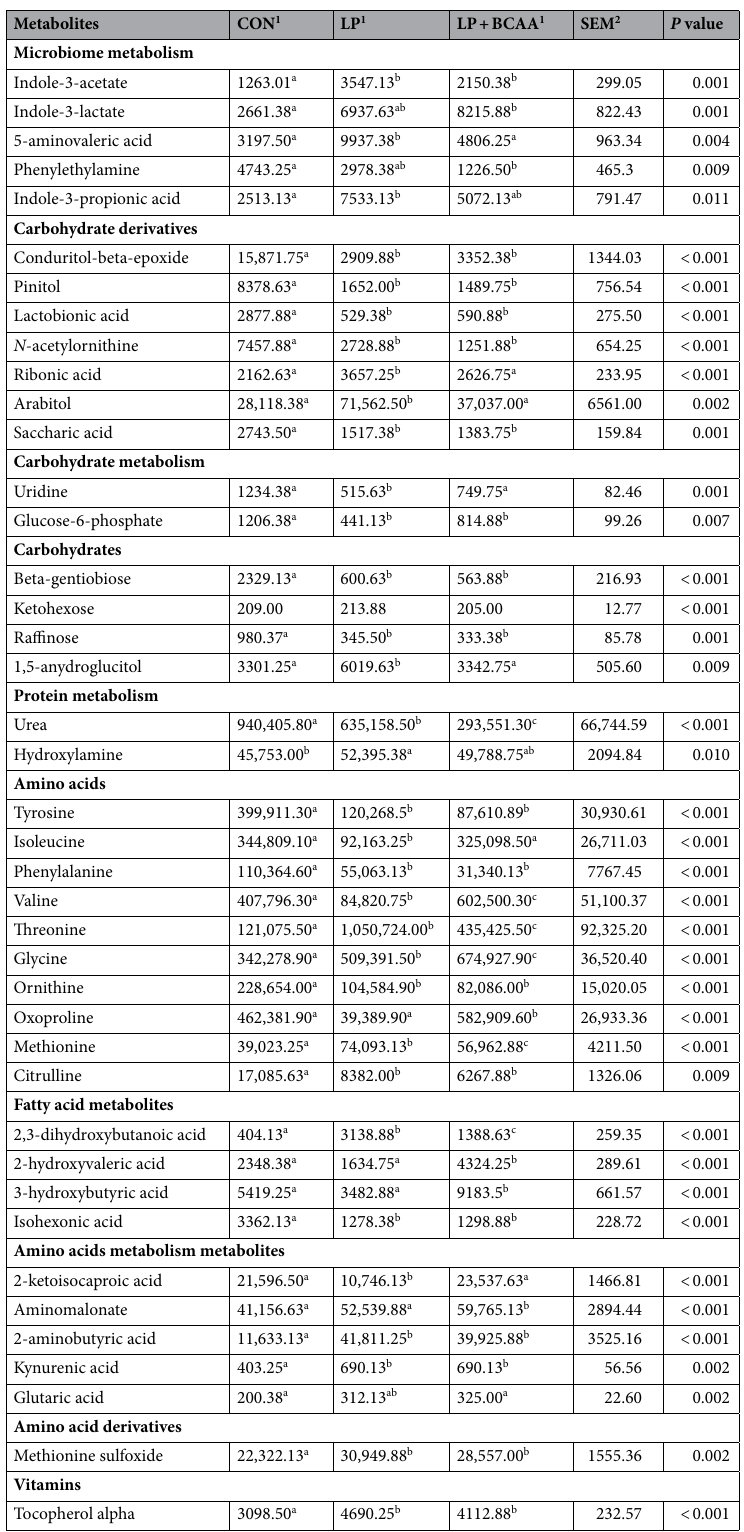
Table 1. Effect of very low protein diets supplemented with branched-chain amino acids on blood metabolomics profile. 1 CON, control diet; LP, low protein diet; LP + BCAA, low protein diet supplemented with branched-chain amino acids. The values are mean peak height. n = 8. 2 SEM, standard errors of means. a,b,c Within a row, values with different superscripts are different ( P ≤